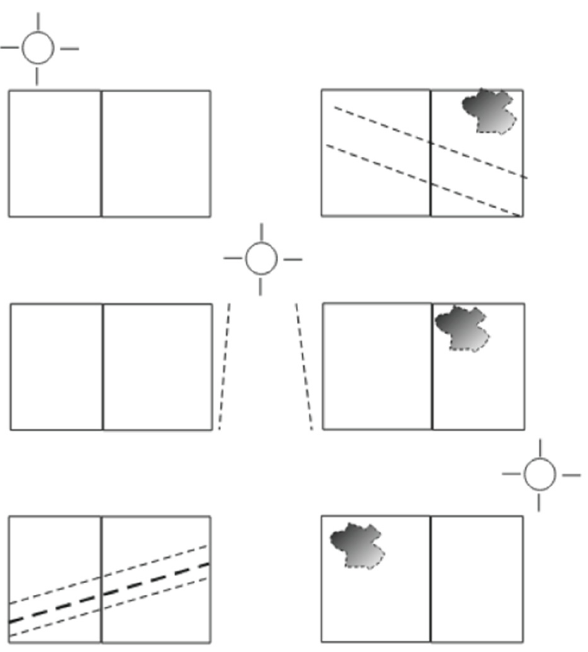
Figure 8. Displacement of the lines and irregular shading areas according to the daily movement of the Sun from east to southwest, in mooring conditions in port.